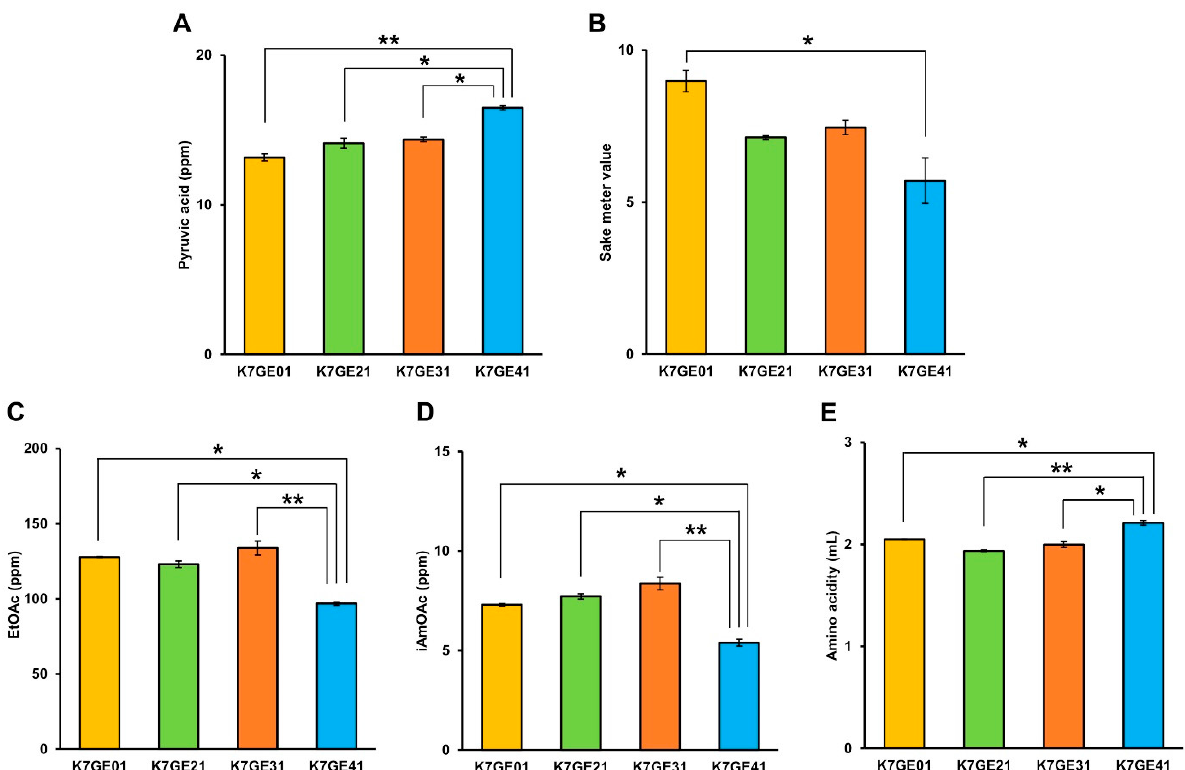
Figure 6. Measurement of pyruvate ( A ), sake meter value ( B ), ethyl acetate ( C ), isoamyl acetate ( D ), and amino acidity ( E ) in sake made with genome-edited strains. Error bars indicate standard error ( n = 3). Asterisks indicate Tukey’s multiple comparison test (* p < 0.05, ** p < 0.01).